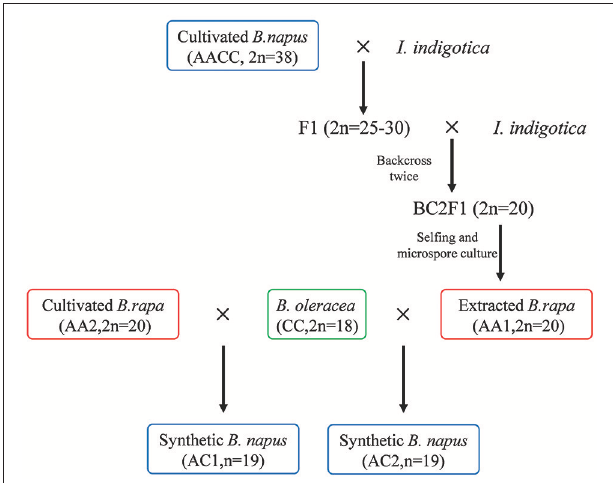
FIGURE 1 | Schematic presentation of the plant materials used in the study. The extracted B. rapa (AA1) is derived from natural B. napus (AACC, 2 n = 38, cultivar “Oro”) after pollination by I. indigotica twice and selfing for generations. The two synthetic hybrids are obtained through hybridization between the extracted and cultivated B. rapa and the same B. oleracea without chromosome doubling. Plant materials used in the study are indicated by differential colored circle. The same colors are also used in the subsequent